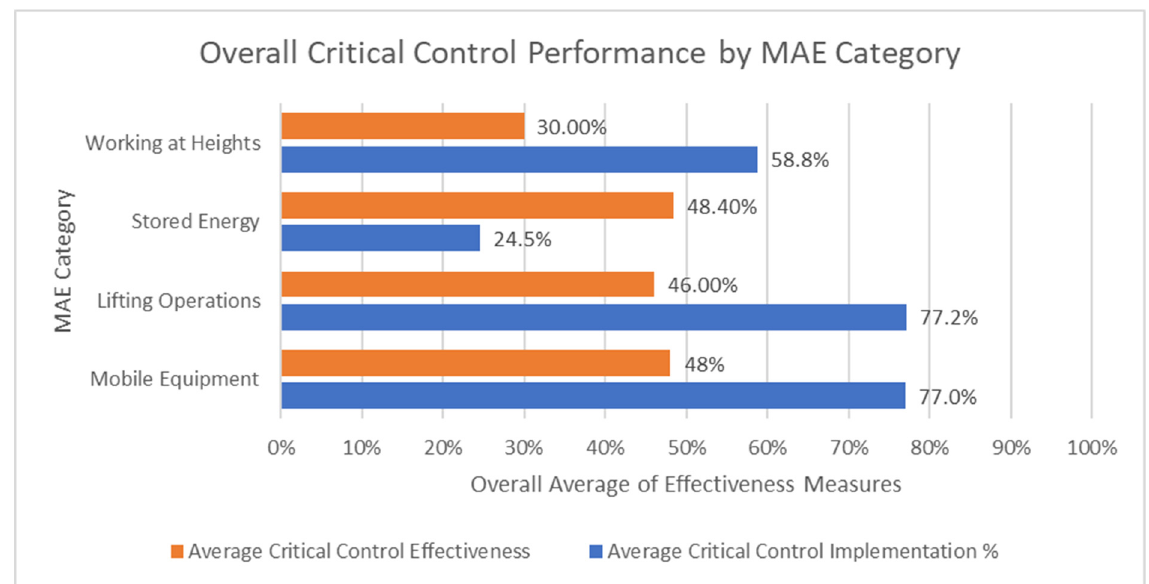
Figure 6. Overall critical control performance by MAE category.